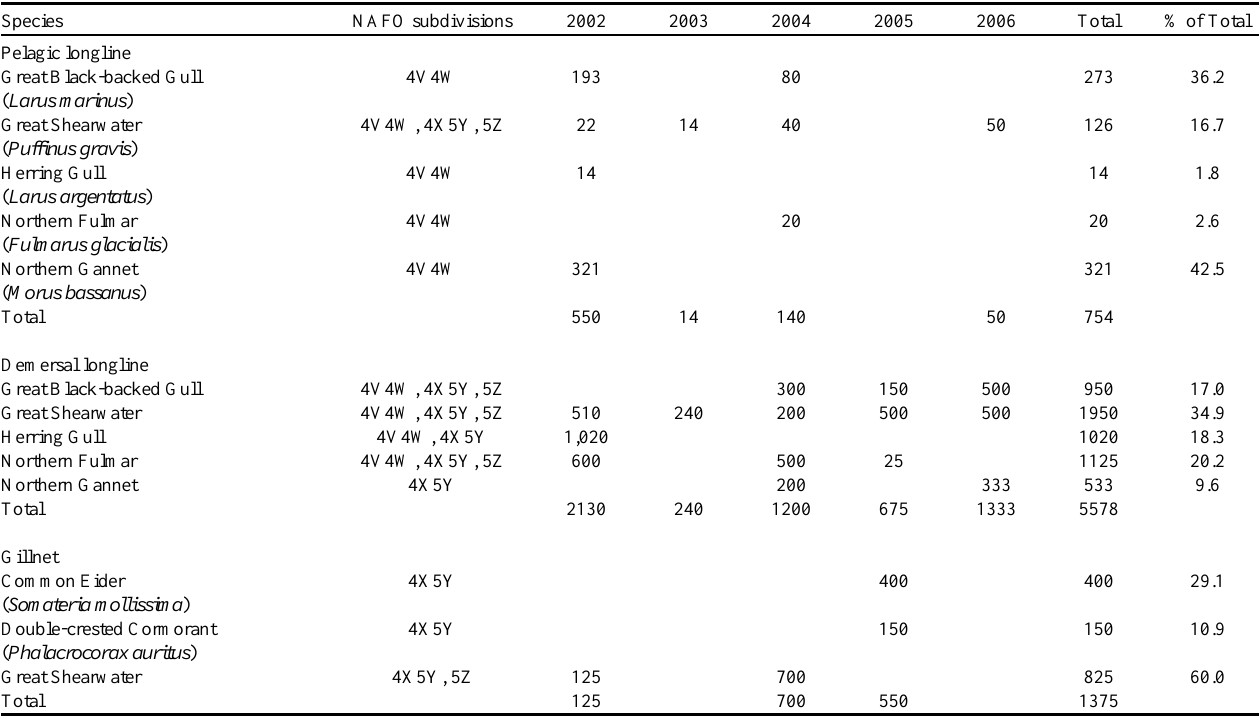
Table 1 . Extrapolated estimates of total numbers of birds incidentally caught in longline (pelagic and demersal) and gillnet fisheries in the Maritimes region based on observer coverage information from Clark et al. (2010) and data collected through the Maritimes Fisheries Observer Program (2002-2006). NAFO = Northwest Atlantic Fisheries